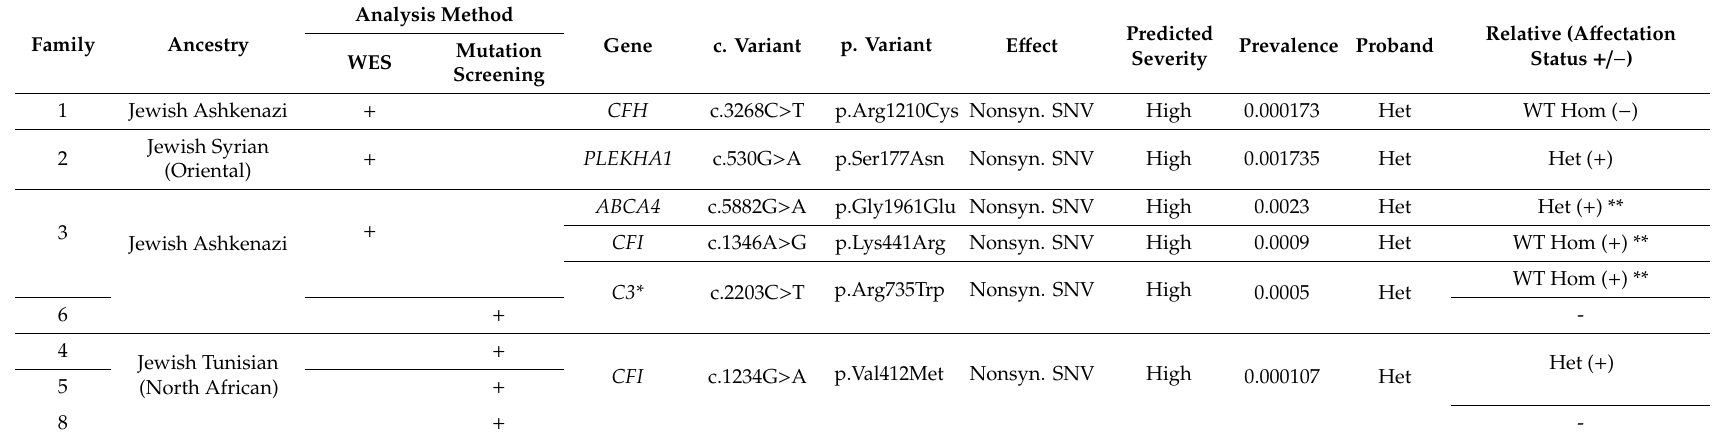
Table 1. Rare variants of high predicted severity (initial WES (whole-exome sequencing) findings and subsequent findings in additional families).